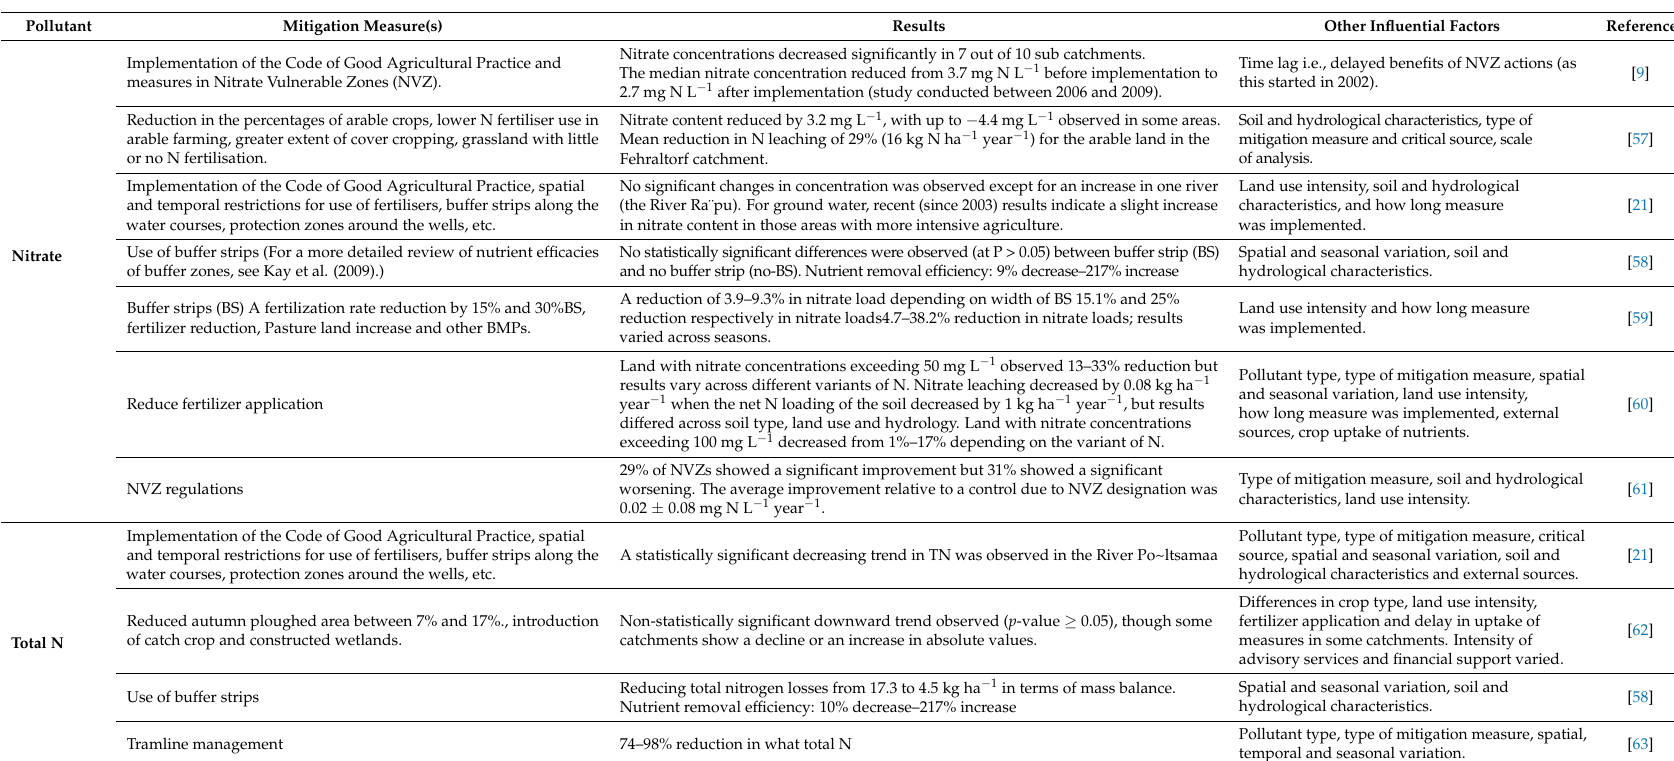
Table 3. Effects of uptake of mitigation measures on water